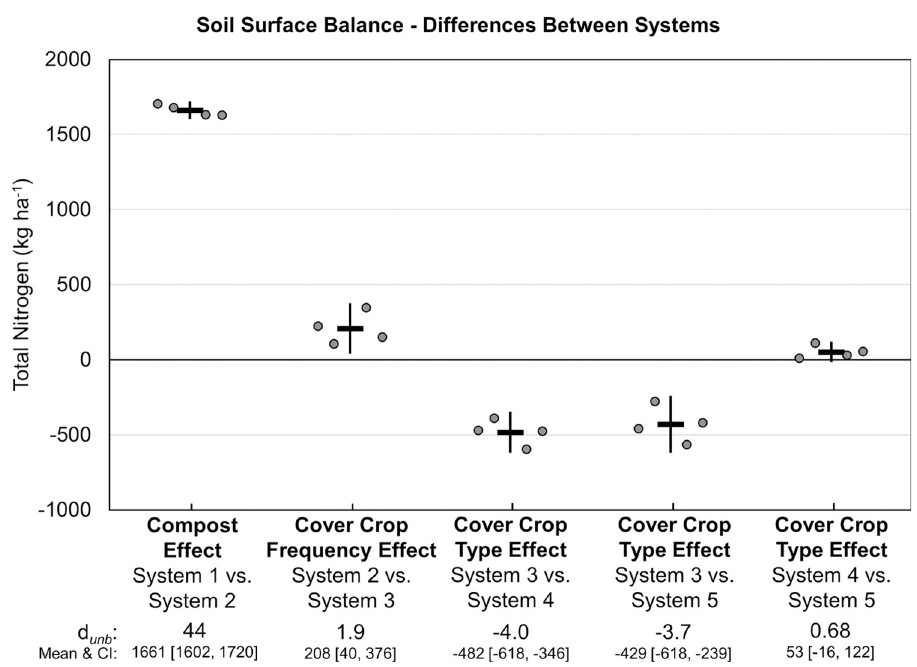
Fig 14. Mean paired difference in cumulative soil surface nitrogen balance between systems over eight years of vegetable production. Measurements were taken in five organic vegetable systems. Systems differed by annual compost additions, cover crop type and cover cropping frequency. System 1 = no compost+legume-rye 4 th year; System 2 = annual compost+legume-rye 4 th year; System 3 = annual compost+legume-rye annually; System 4 = annual compost+mustard annually; System 5 = annual compost+rye annually. Error bars are 95% confidence intervals (CI) around the mean (horizontal line). Data points are replicates 1 through 4 averaged across years and are clustered around the mean left to right so as not to obscure the mean and CI. The standardized effect size (Cohen’s unbiased d , d unb ) is shown below the